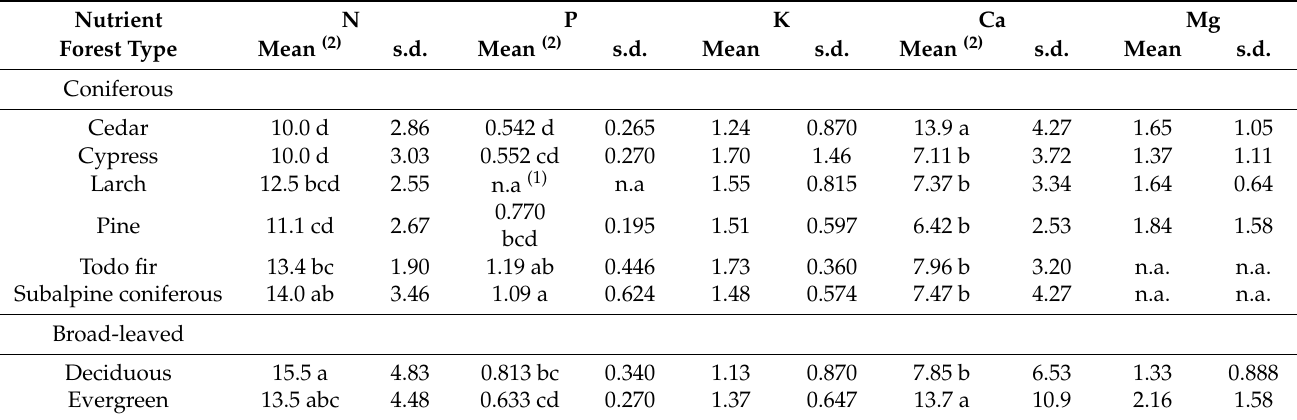
Table 2. Mean and standard deviation (s.d.) of total nutrient concentrations (g kg − 1 ) in the forest floor of predominant forest types.